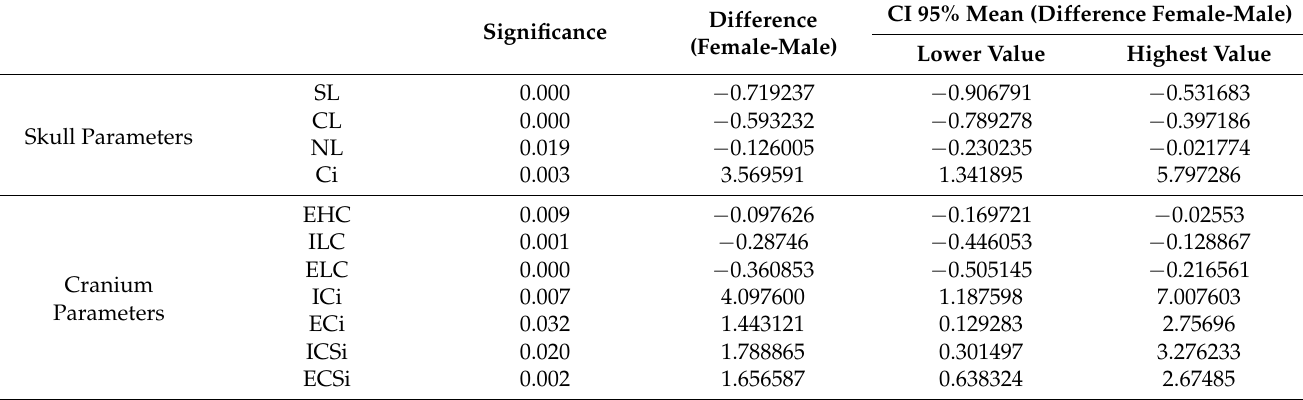
Table 3. Results of the t-test for independent samples in which the significance is less than 0.05, with a statistically significant difference in measurements between the males and